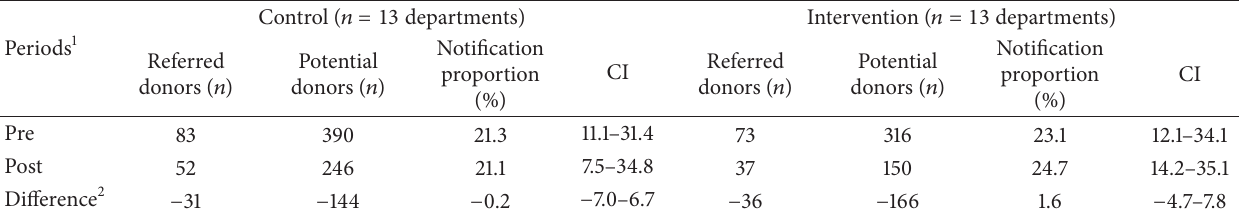
Table 1: The number of donors and notifications per group and